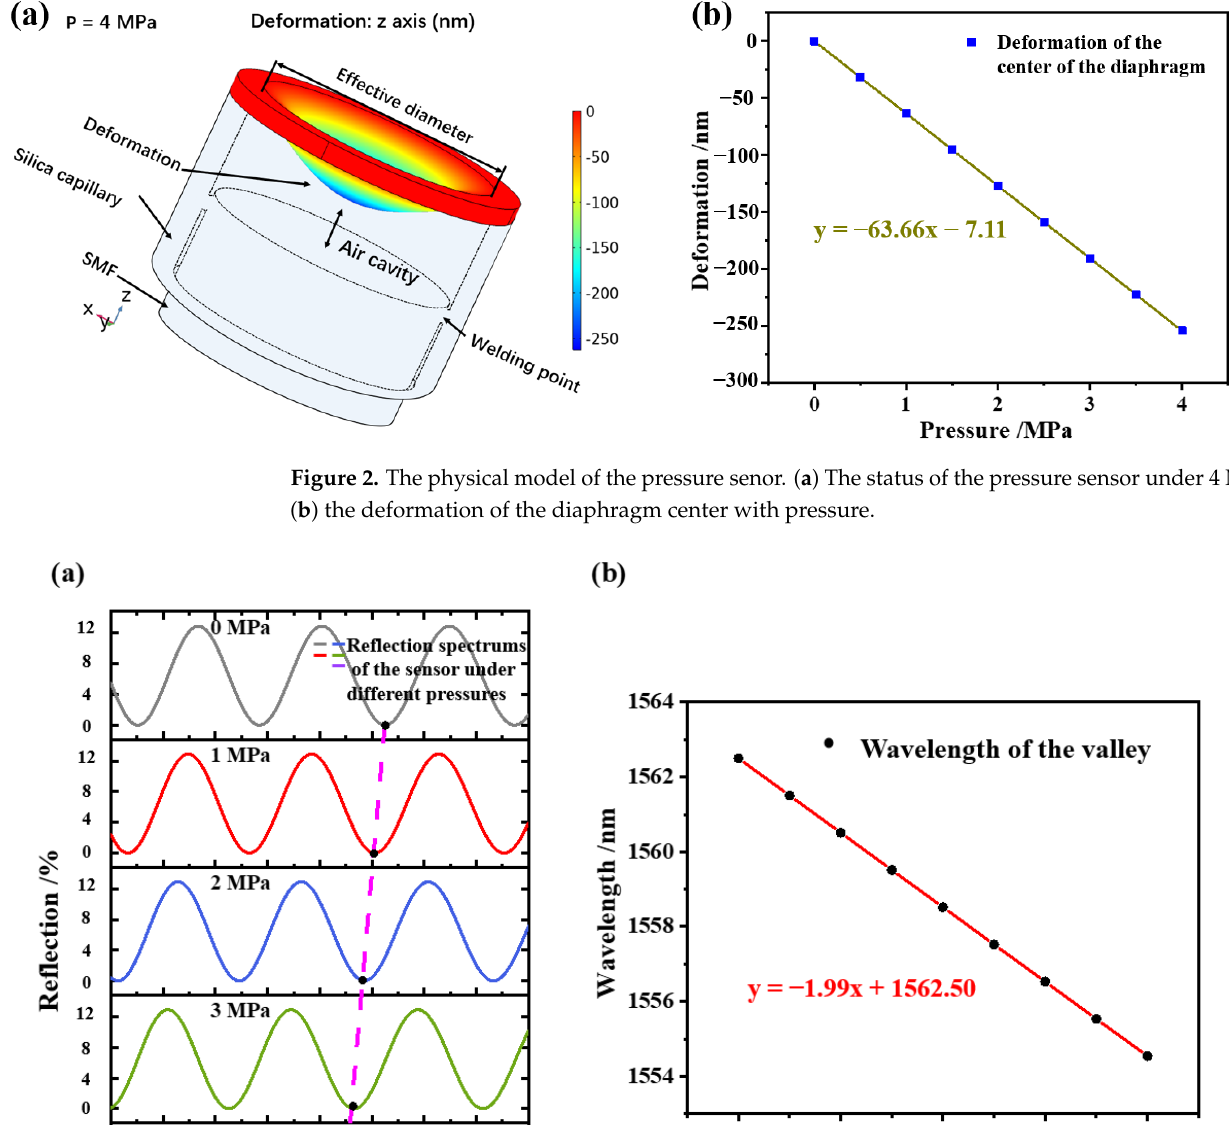
Figure 2. The physical model of the pressure senor. ( a ) The status of the pressure sensor under 4 MPa; ( b ) the deformation of the diaphragm center with pressure.